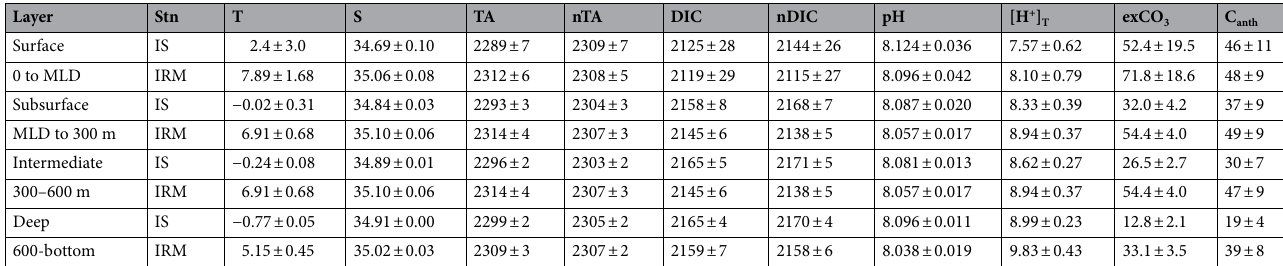
Table 1. Average and standard deviations of the in situ temperature (T in °C), salinity (S), Total Alkalinity (TA in µmol kg −1 ), salinity-normalized alkalinity (nTA in µmol kg −1 ), total dissolved inorganic carbon (DIC in µmol kg −1 ), salinity-normalized dissolved inorganic carbon (nDIC in µmol kg −1 ), in situ pH in total scale (pH T ), total hydrogen ion concentrations ([H + ] T in nanomol kg −1 ), ion carbonate concentration excess over aragonite saturation (exCO 3= in µmol kg −1 ), and anthropogenic CO 2 (C anth in µmol kg −1